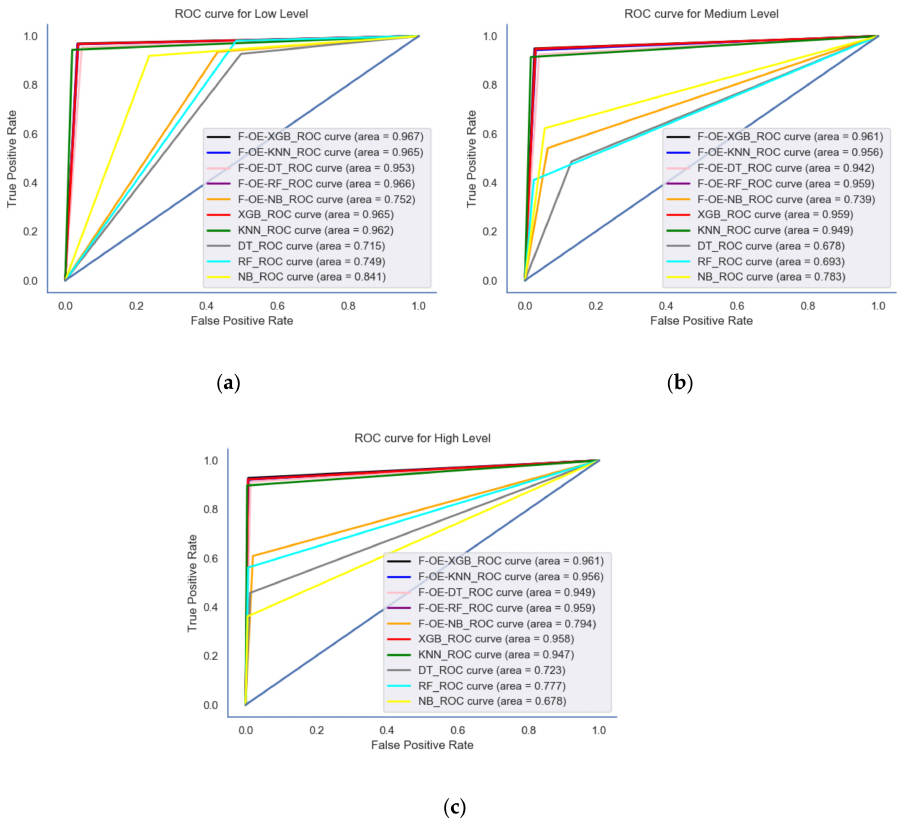
Figure 7. Multi-class ROC curves of the compared F-OE algorithms for low, medium, and high levels: ( a ) ROC curve for the low-level class, ( b ) ROC curve for the medium-level class, and ( c ) ROC curve for the high-level